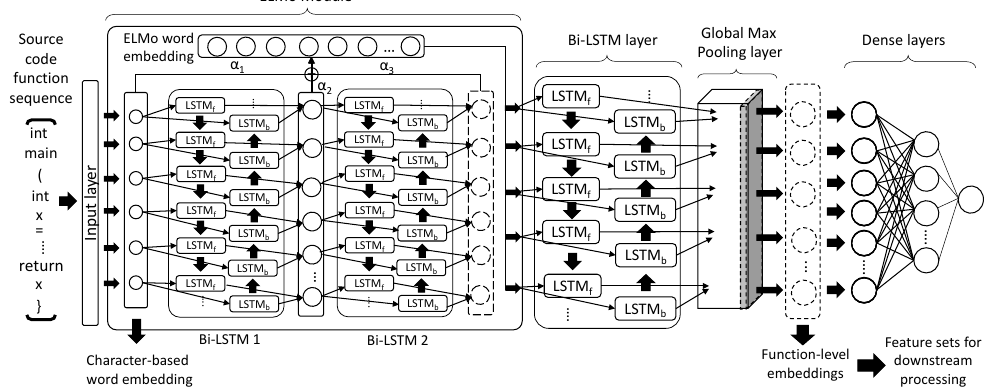
Figure 4. The structure of the proposed deep neural network with the ELMo module built-in for extracting function-level embeddings. The ELMo module exposes 3 trainable weights— α 1 , α 2 and α 3 —for the aggregation of the character-based word embedding layer, and the two Bi-LSTM layers, respectively. We remove the mean-pooling layer and connect the ELMo word embedding layer to another Bi-LSTM layer, followed by a global max pooling layer to form the embedding framework. During the training phase, three dense layers are added to the global max pooling layer to train the network. When training is completed, the source code functions can be fed to the input layer and the embeddings are the output of the third last layer (global max pooling